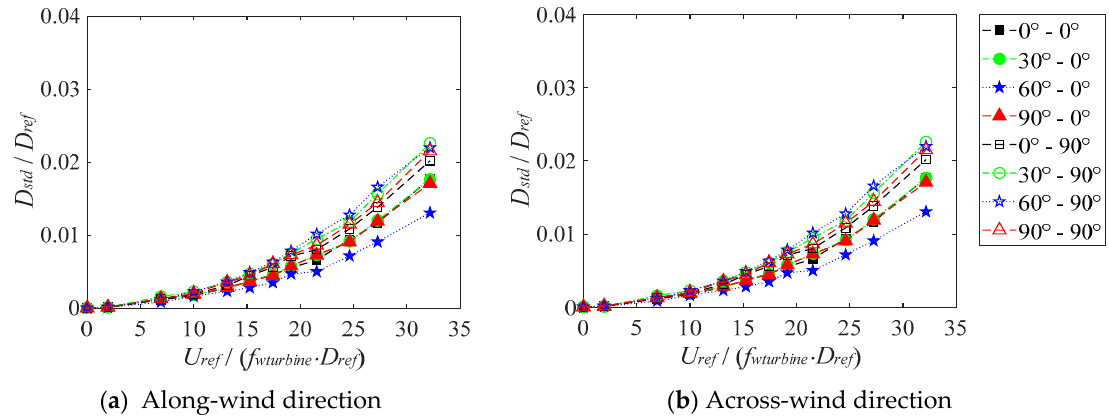
Figure 6. Fluctuating displacements for square wind turbine.